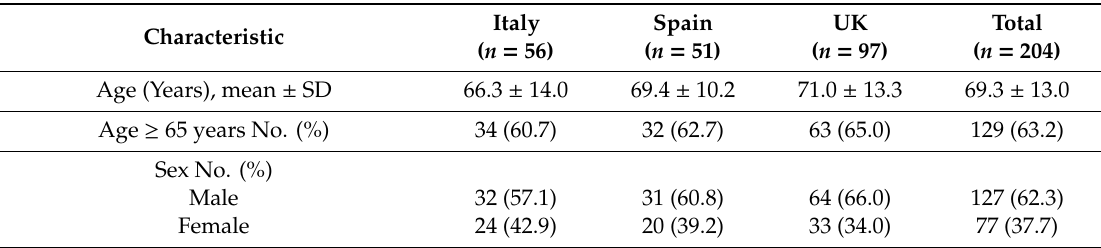
Table 1. Patient